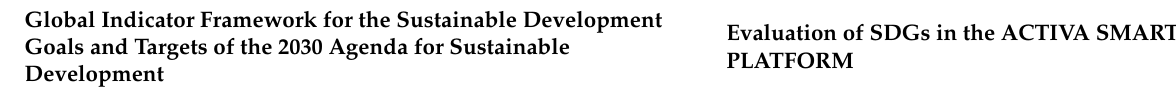
Table 2. Evaluation and implementation of SDG 7 in the ACTIVA smart